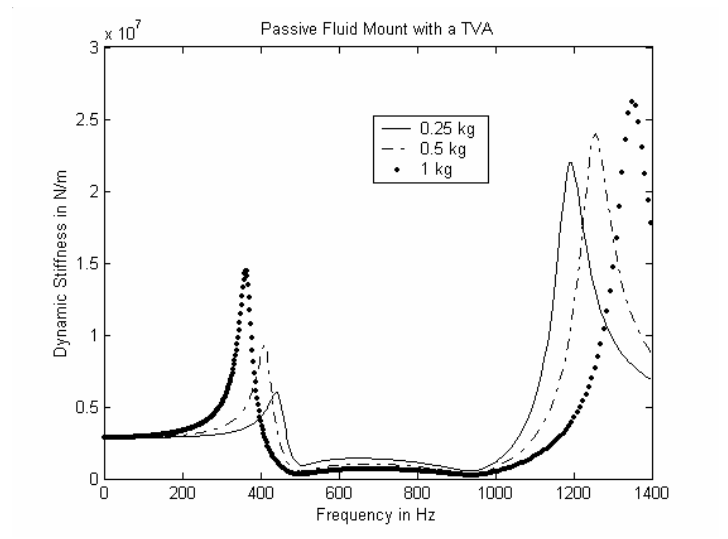
Fig. 13. Effect of TVA mass on dynamic